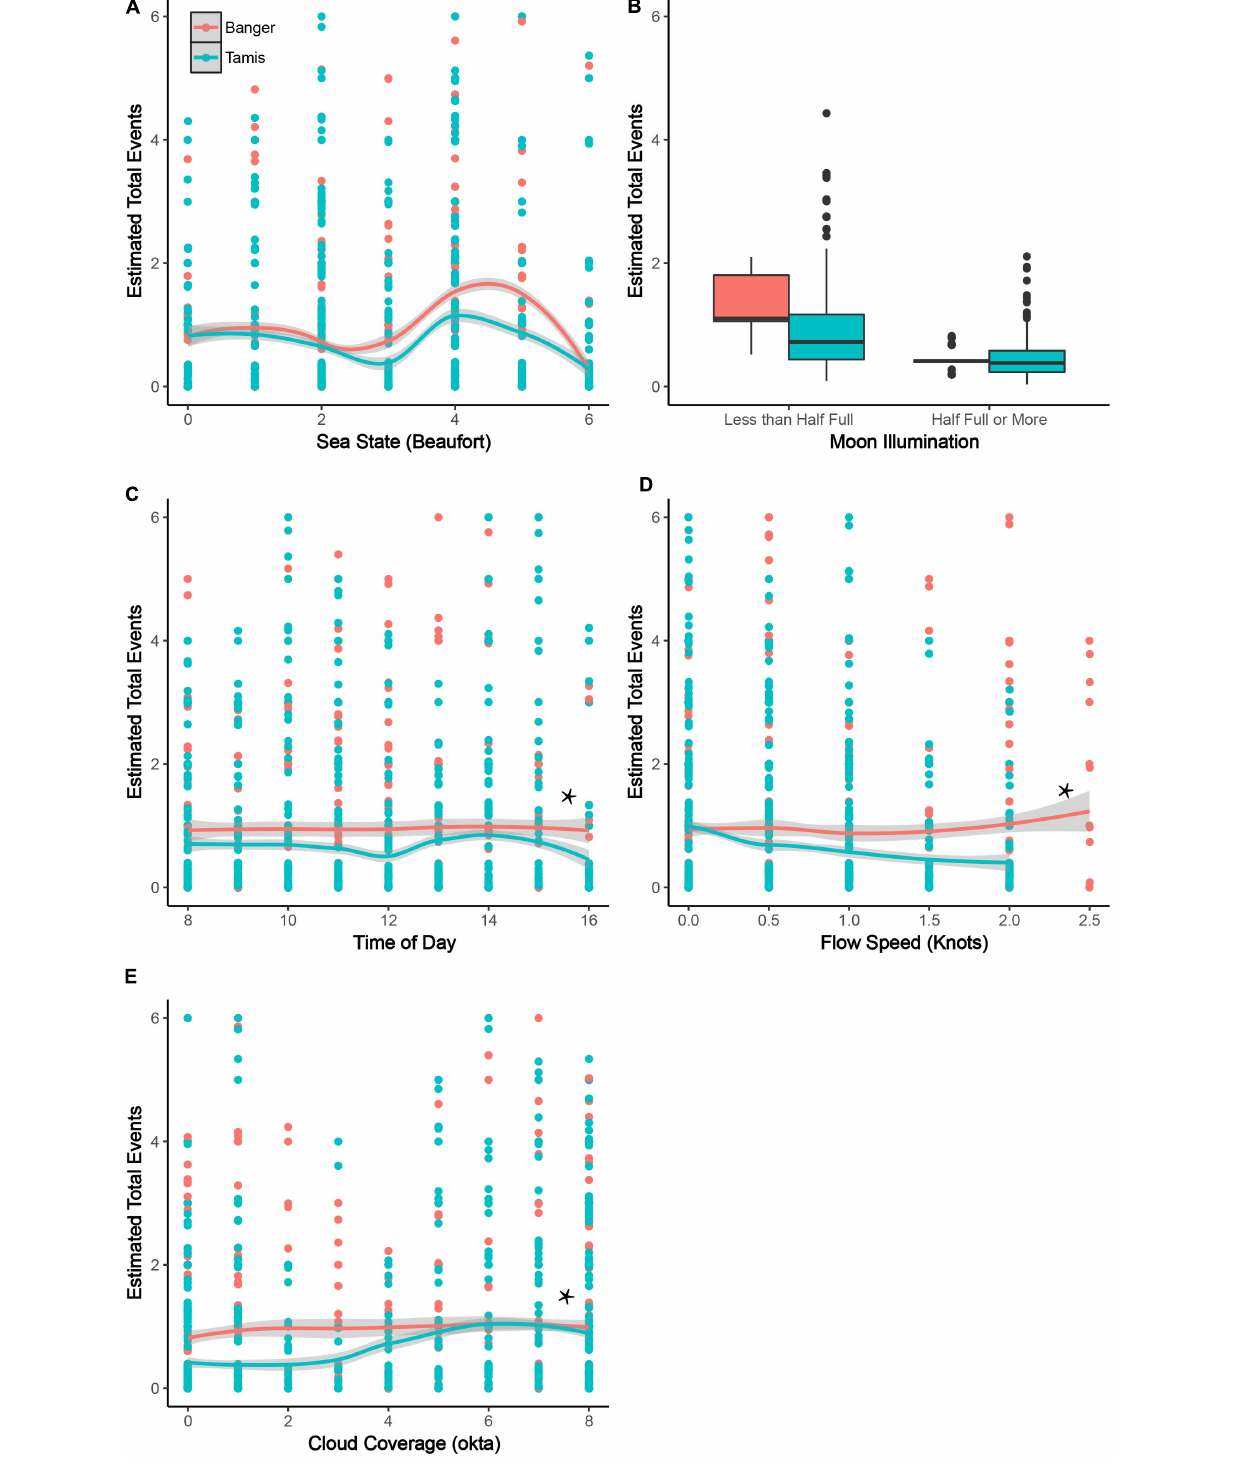
Frontiers in Marine Science |